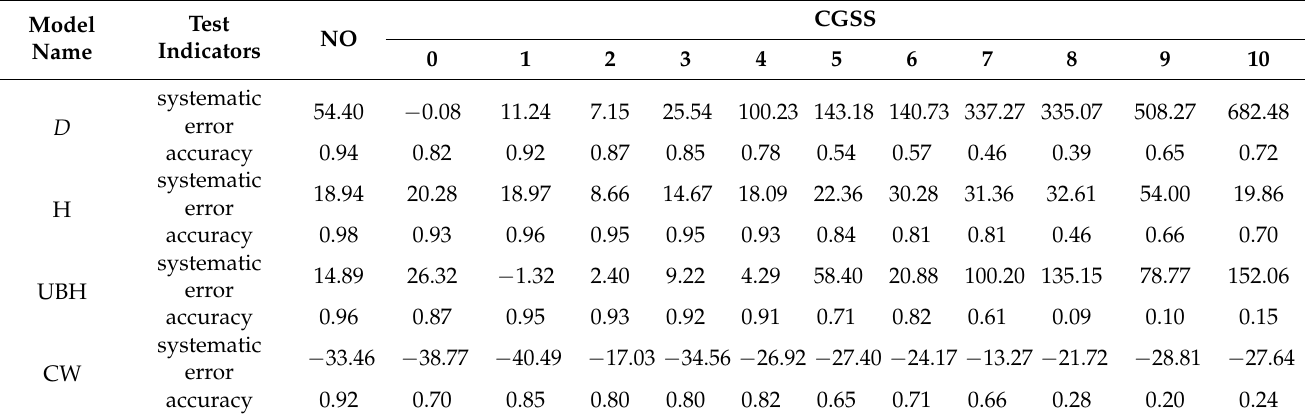
Table 8. Test indicators of morphological − structural growth model of Chinese fir based on